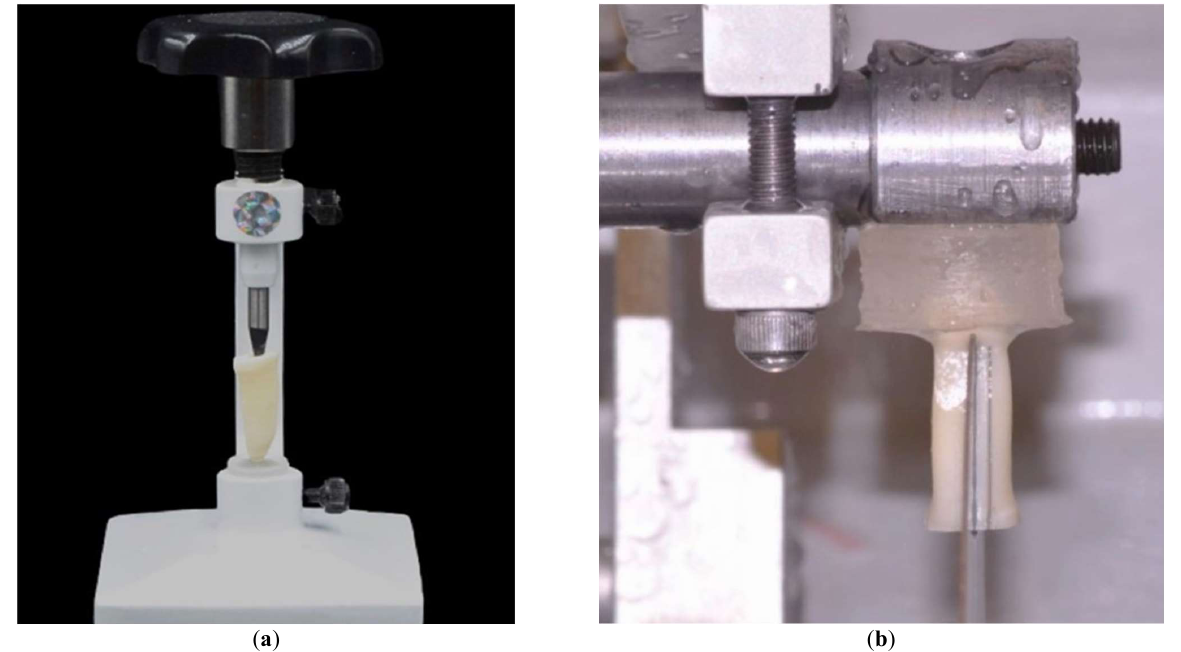
Figure 2. Sample sectioning: root centred on acrylic stump ( a ) and vertical root sectioning ( b ).